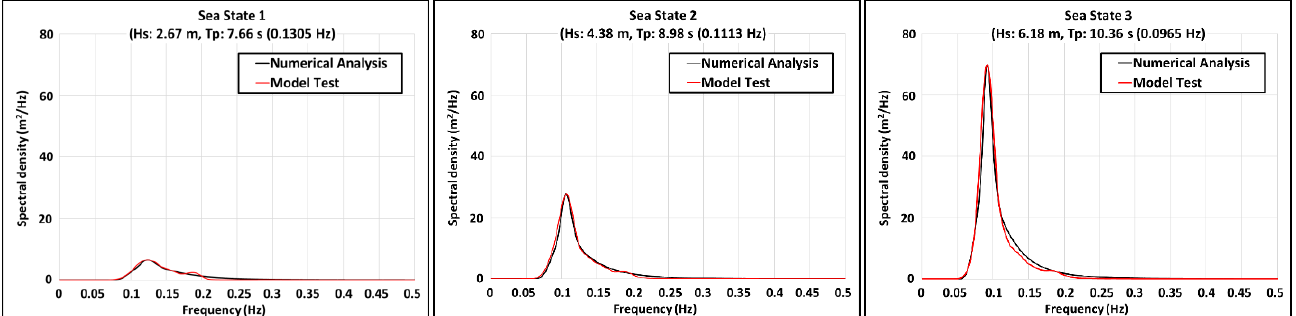
Figure 11. Irregular wave spectrum comparison between model test and numerical analysis.